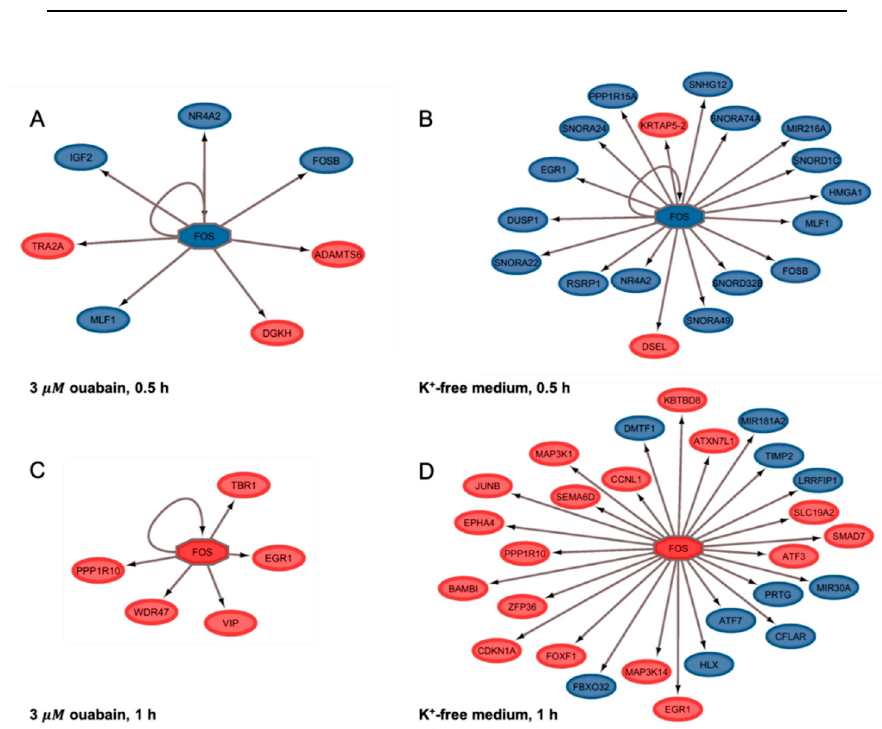
Figure 5. Potential transcriptional regulation in HUVEC by FOS, triggered by Na,K-ATPase inhibition by 3 µ M ouabain ( A , C ) or K + -free medium ( B , D ) at the early stages of Na + i / K + i gradient dissipation. Upregulated and downregulated genes are shown in red and blue, respectively.